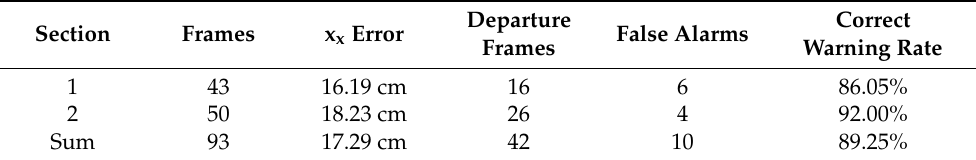
Table 5. The experimental result of the curved roads.